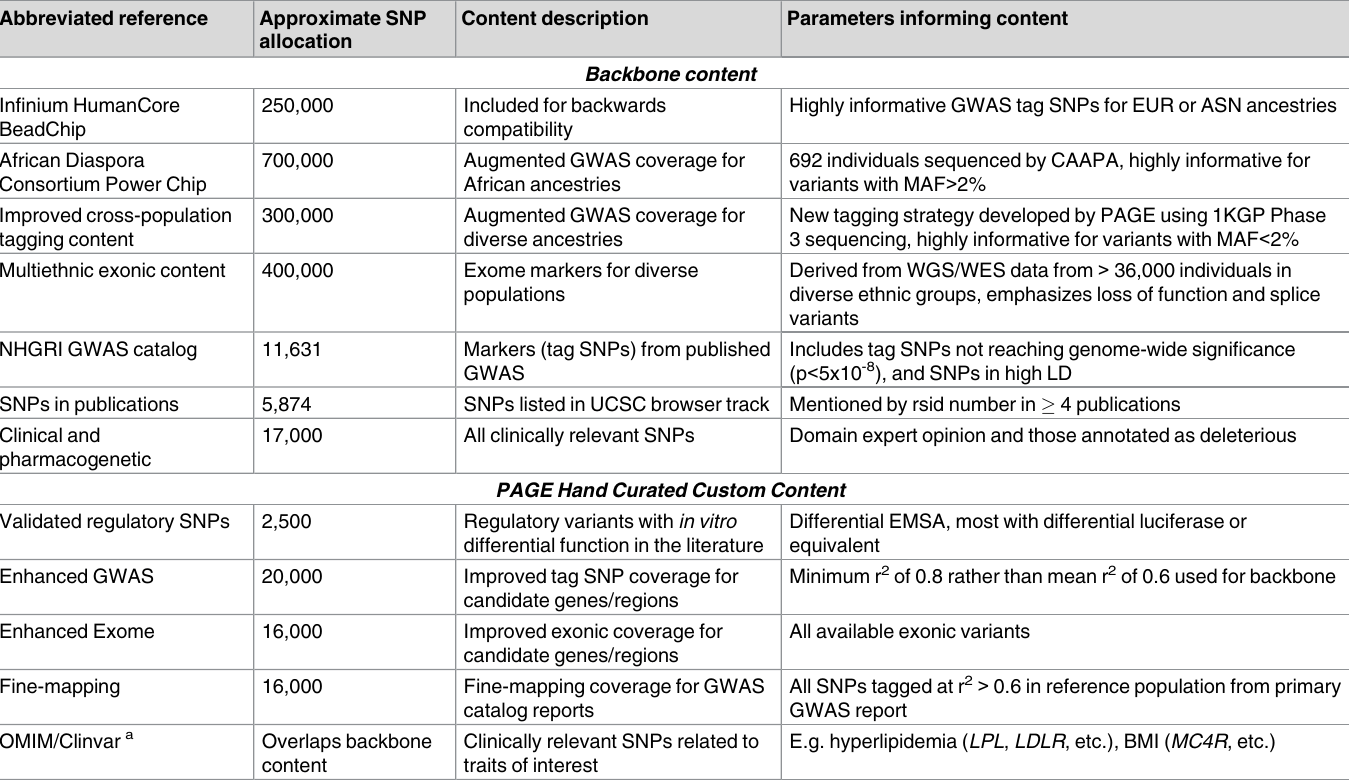
Table 1. Marker allocation used for design of